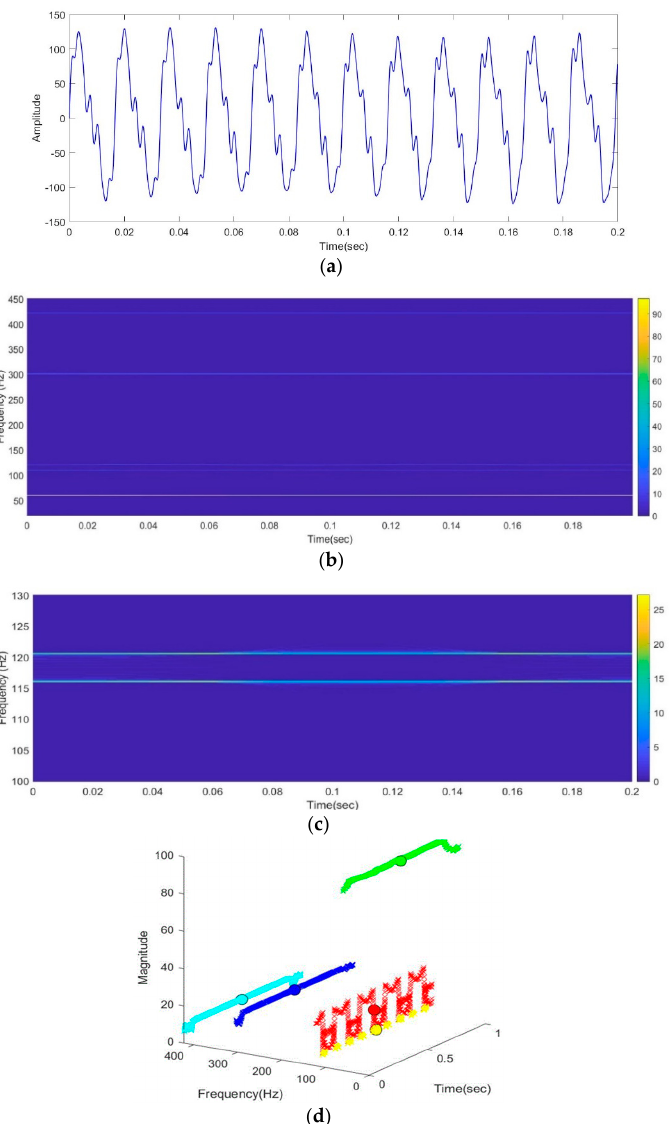
Figure 9. ( a ) The simulated waveform, ( b ) the detected TF ridges, ( c ) zoomed-in view of two TF ridges with close frequen- cies by the proposed method, ( d ) the detected central frequencies shown in color dots of each rigid of ( b ) using DBSCAN. Table 2. Performance of frequency estimation of the proposed